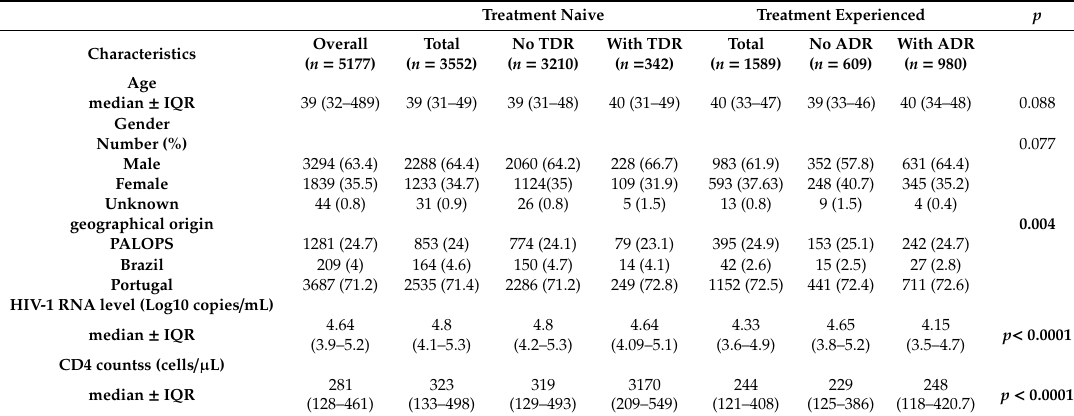
Table 1. Characteristics of migrants and Portuguese population followed up in Portugal, 2001–2017. Treatment Naive Treatment Experienced